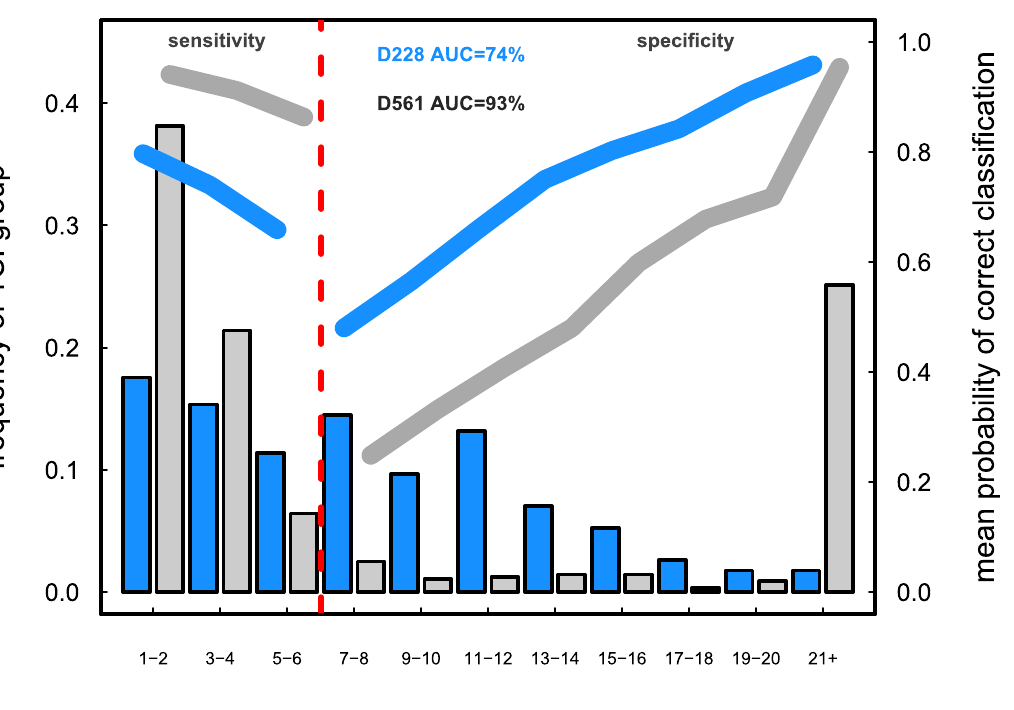
Fig 8. Comparing the mean performance (i.e., mean of ^ p k over S = 1000 simulations) of the same hypothetical HIV recency assay using the two empirical TSI distributions (note different y axis, with the left y axis representing the frequency of each of the 2-month TSI groups or bins, and the right y axis representing the mean of ^ p k ). The assay performs better overall in the dataset D561 which has a bimodal TSI distribution (dark gray, AUC = 93%) than in dataset D228, which has a TSI distribution with a large fraction of cases around the recency cutoff of 6 months (blue, AUC = 74%). In addition, the assay ’ s sensitivity as a function of TSI is also higher in dataset D561, however, its speci fi city is higher in dataset D228. For the case of D561, in the range of 6 to 15 months the assay does worse, on average, than a “ coin toss ” (mean probability < 0.5). Parameter values: u = 0.2, h =